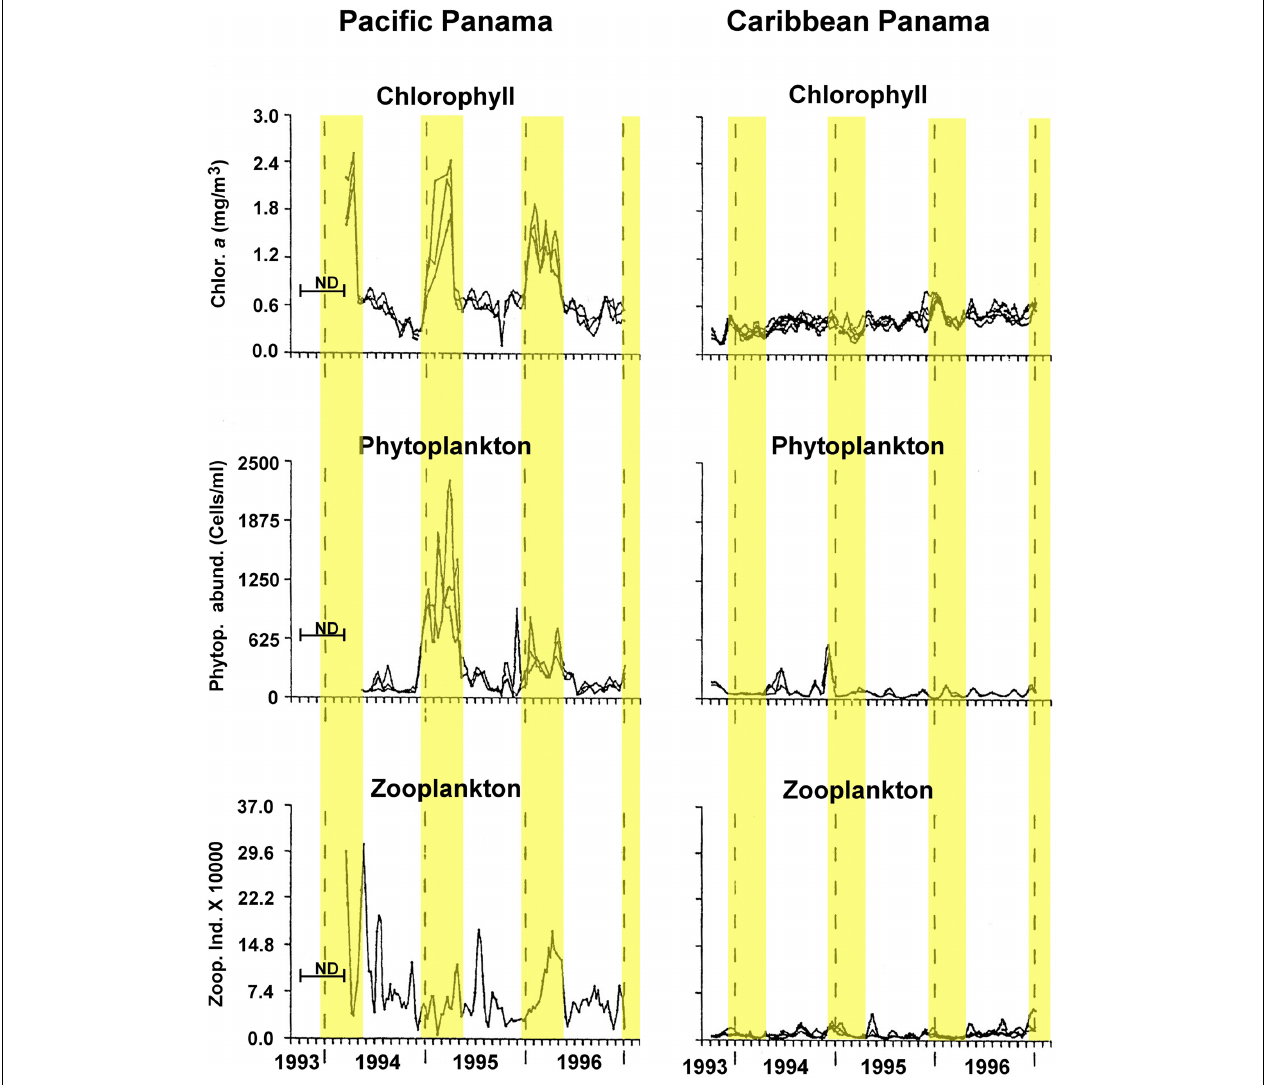
FIGURE 1 | Seasonal changes in chlorophyll, phytoplankton and zooplankton abundance in the Caribbean and Pacific study areas. Redrawn and modified after Figure 5 of D’Croz and Robertson, 1997. Yellow highlighting bands indicate timing of the cool season as used in analyses